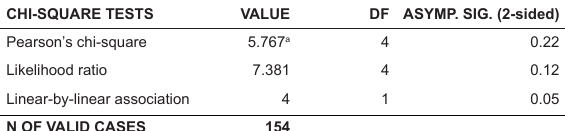
TABLE 4 Chi-square tests for duration of an HIV/AIDS